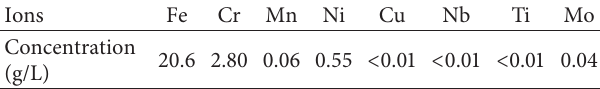
Table 2: Concentration of metal ions in industrial H